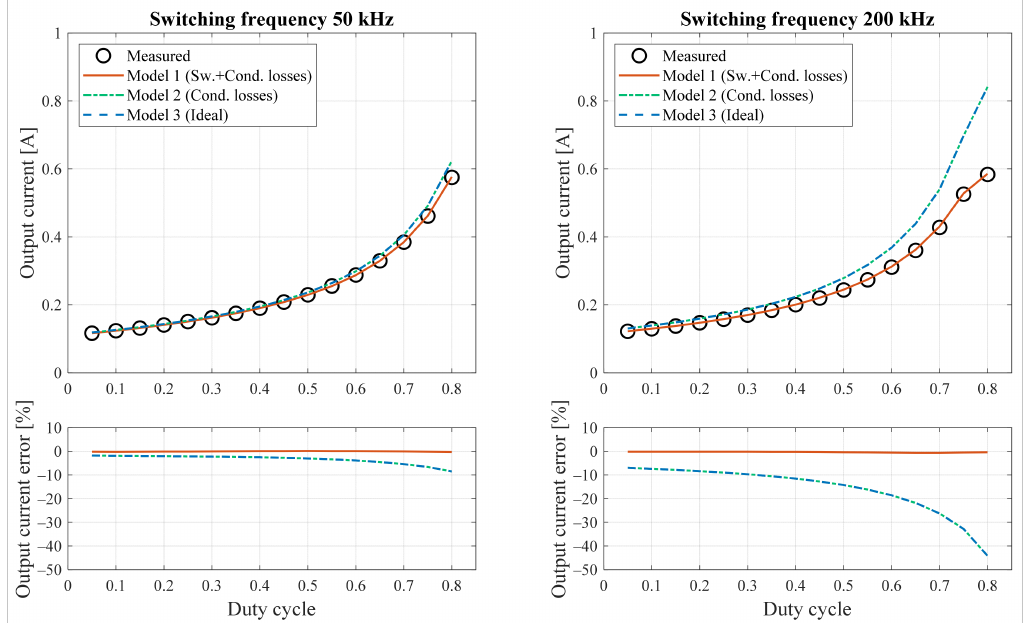
Figure 16. Predicted output current and relative error for known input voltage, input current and duty cycle at switching frequencies f sw = 50 kHz and 200